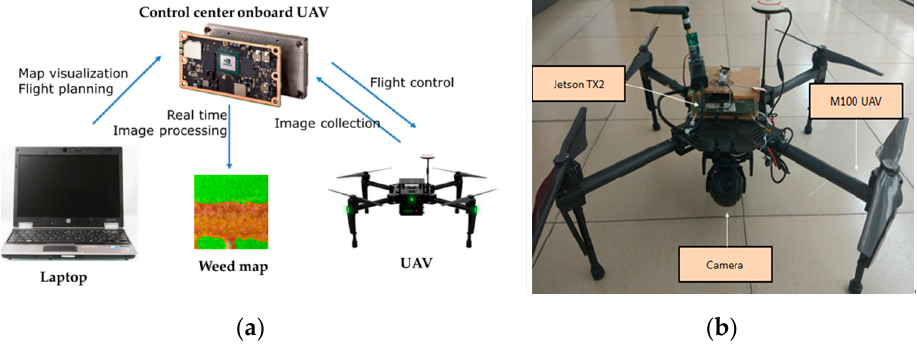
Figure 1. Composition of the developed system. ( a ) Components of the developed system. ( b ) Main components of the UAV